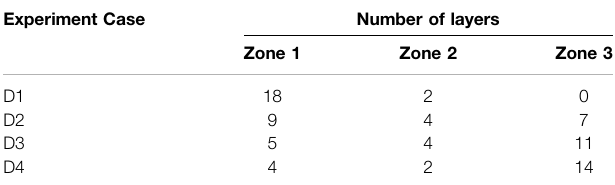
TABLE 4 | Classi fi cation of layers deposition process according to temperature gradient for experiment cases D1-D4 (Effect of dwell time). Experiment